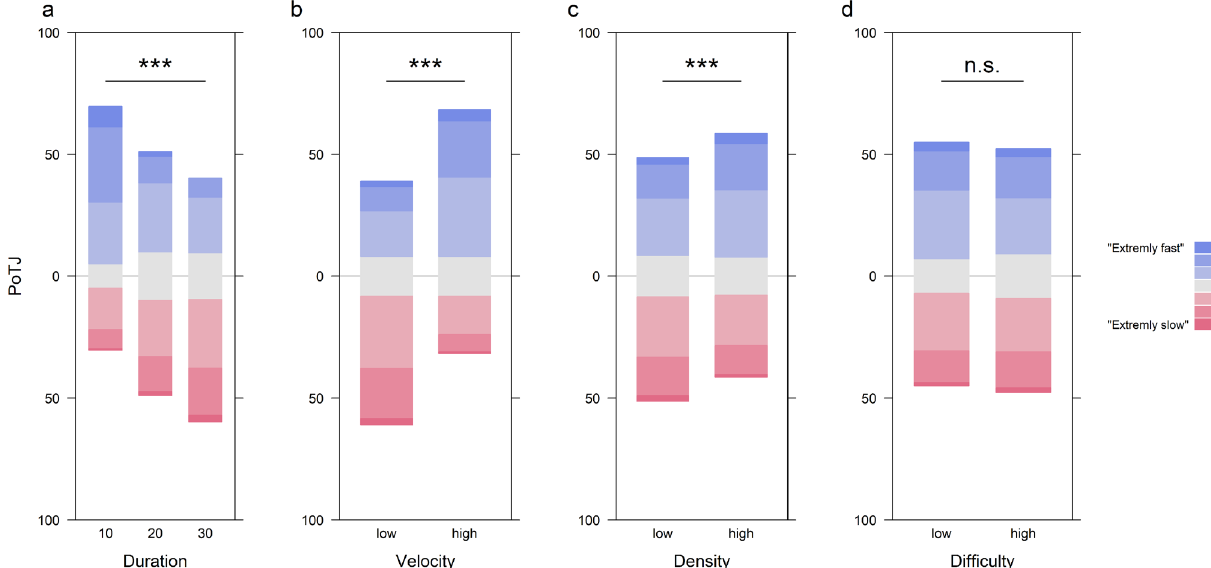
Figure 3. Diverging bar charts of PoTJs for the three different stimulus durations (10, 20, and 30 s; a ) and two different levels of velocity ( b ), density ( c ), and difficulty ( d ). Each bar represents 100% of all responses within the respective condition with colors (red to blue) illustrating the distribution of responses over the 7 different levels of the PoTJ scale from “extremely slow” to “extremely fast”. In order to enhance comparability between factor levels, bars are aligned to the 4th level (center) of the PoTJ scale. Asterisks indicate significant differences between factor levels (* < 0.05; ** < 0.01, *** < 0.001, n.s.: not